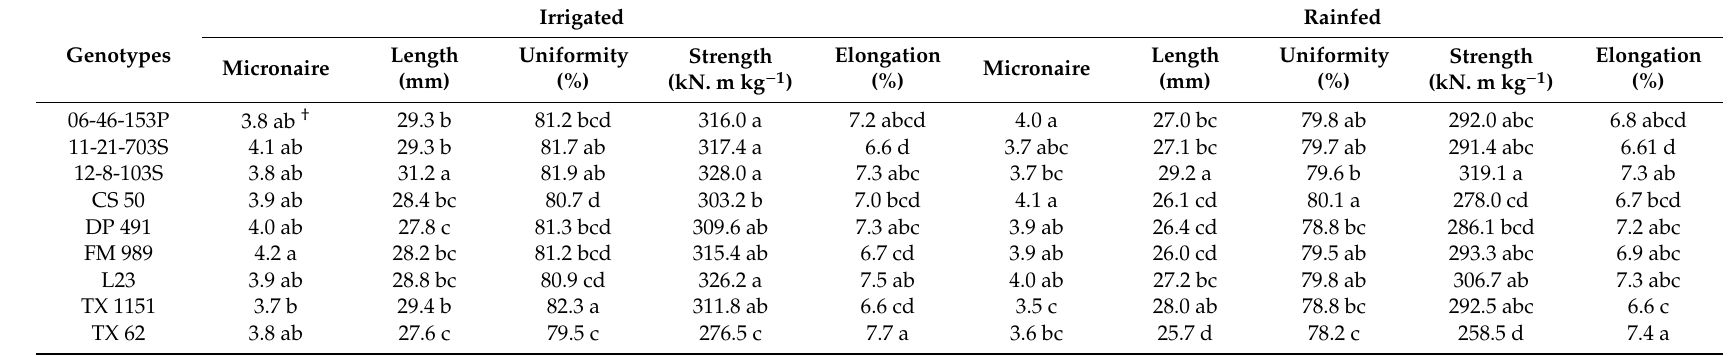
† Means with the same letters are not significantly di ff erent at p <